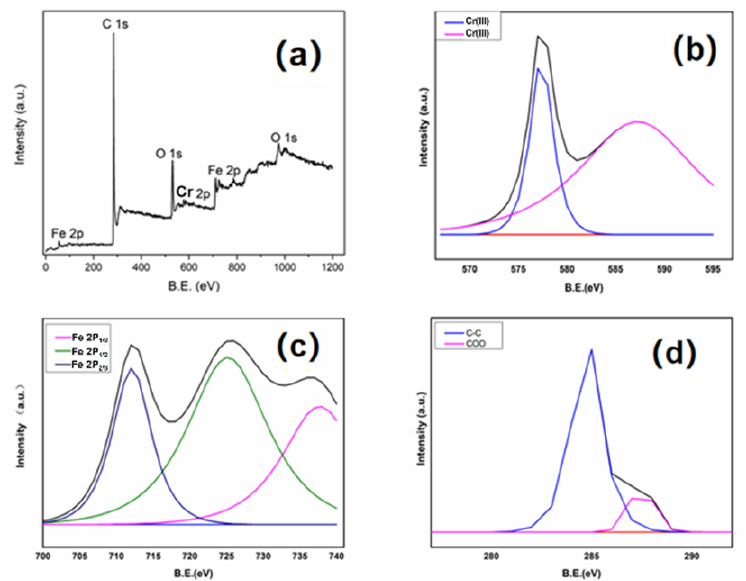
Figure 13. The XPS spectrum of Fe/CA after treating with Cr(VI) ( a ) and the corresponding decon- voluted Cr2p ( b ), Fe2p ( c ), and C1s ( d ) spectra of Fe/CA.